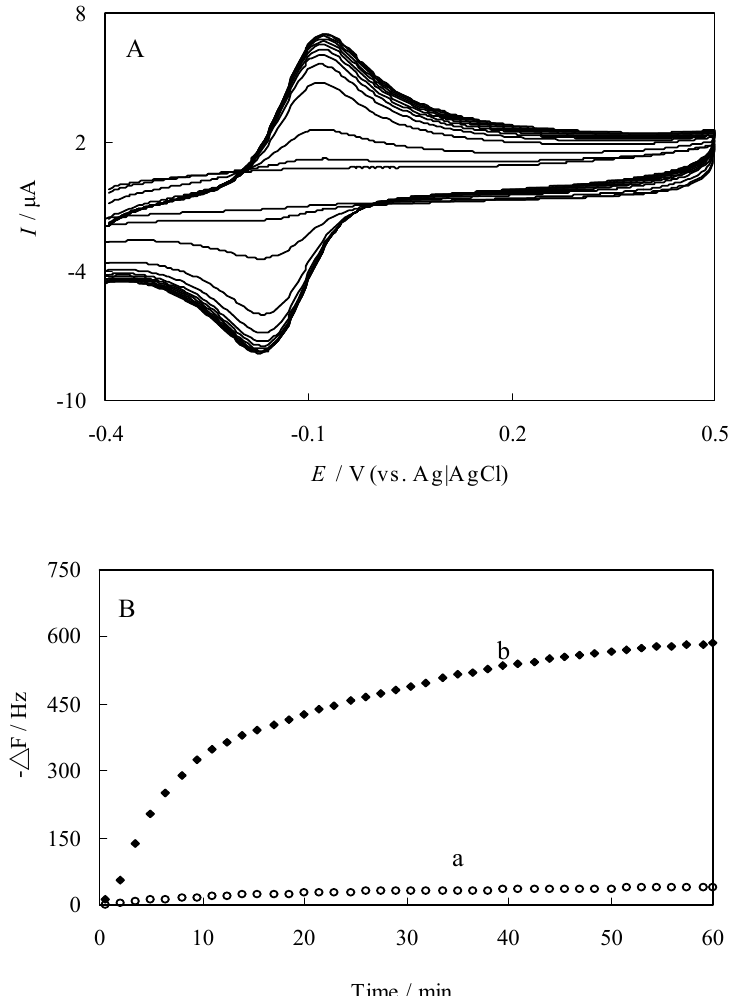
Figure 1. (A) Cyclic voltammograms of DNA-PADDA film in a 0.05 M PBS (pH 7.4) containing 2 × 10 -4 M Fe(4-TMPyP) obtained at different soaking times (each 5 minutes) from inner to outside. Scan rate, 200 mV s -1 . (B) In-situ monitoring of the frequency decreases (- △ F ) with the time for the immobilization of 2 ×10 -4 M Fe(4-TMPyP) in pH 7.4 PBS onto (a) a bare Au/quartz crystal, and (b) a DNA-PADDA modified Au/quartz crystal